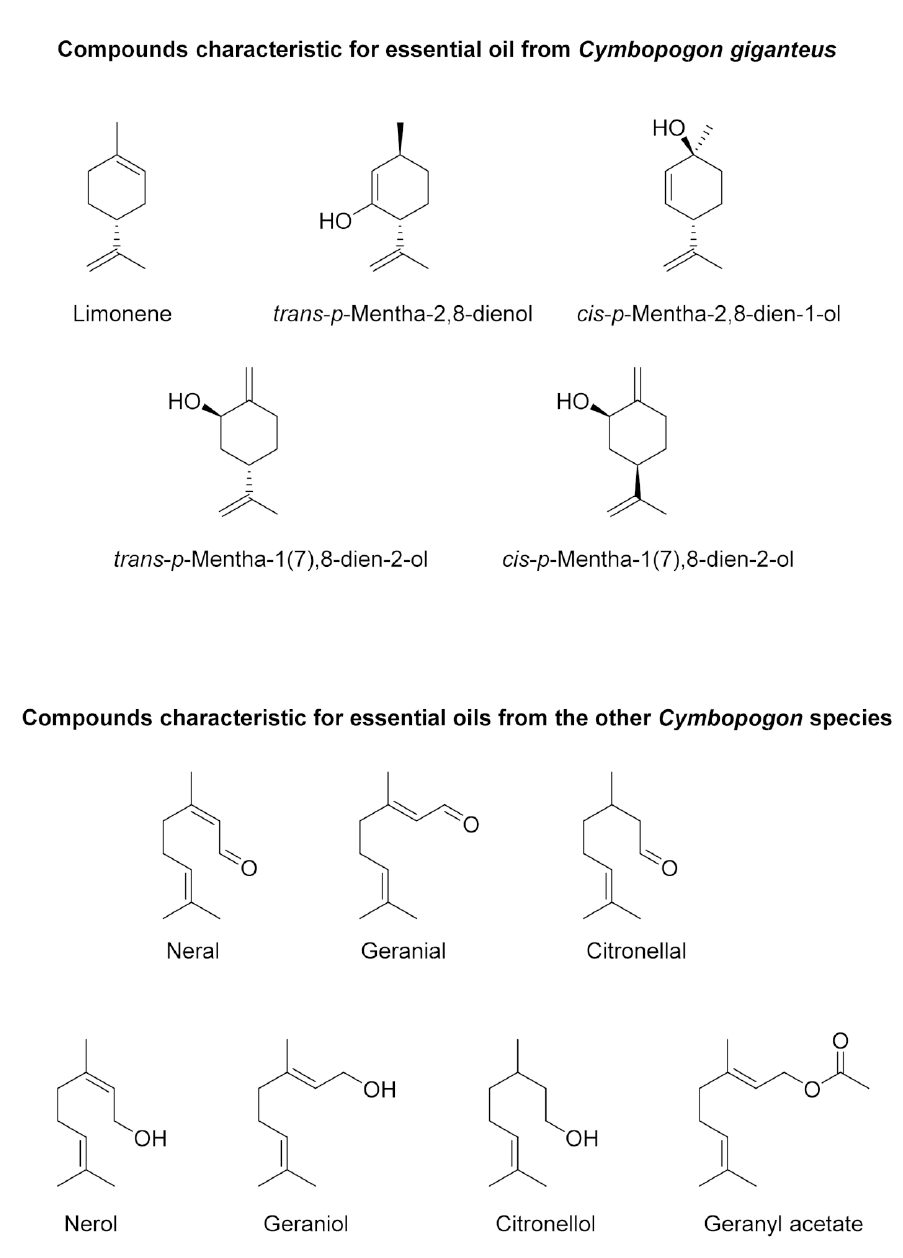
Figure 1. The most characteristic components of the analyzed essential